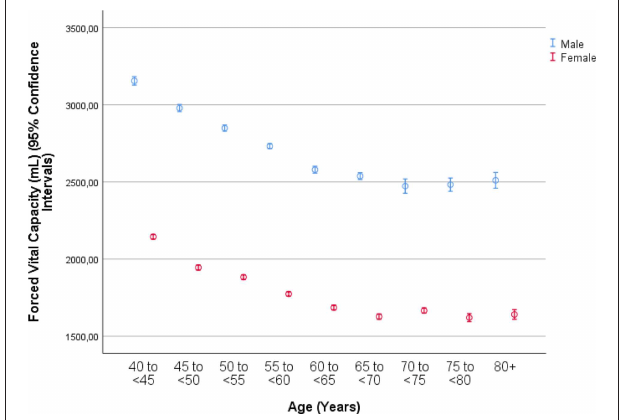
FIGURE 1 | Graph showing the distribution of the forced vital capacity, stratified by age and gender, in the Ural Eye and Medical Study.